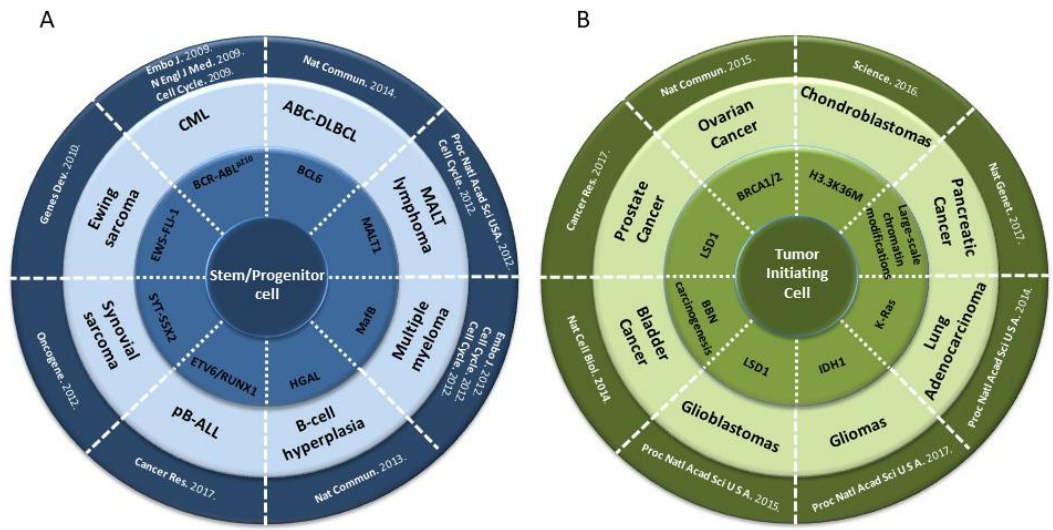
Figure 3. Driving of cancer by a malignant epigenetic stem cell rewiring. Different types of mesenchymal ( A ) and epithelial ( B ) malignancies have shown that the contribution of oncogenes to cancer development is mainly mediated through the epigenetic reprogramming of the cancer-initiating target cell. As illustrated, specific genotype alterations associated to human cancer (medium circle) give rise to specific phenotypes (outer circle) when targeted to the stem cell/progenitor compartment (see text for details). Chronic Myeloid Leukemia (CML), Activated B-Cell Diffuse Large B-Cell Lymphoma (ABC-DLBCL), precursor B-cell Acute Lymphoblastic Leukemia (pB-ALL), N -butyl- N -4-hydroxybutyl nitrosamine (BBN).